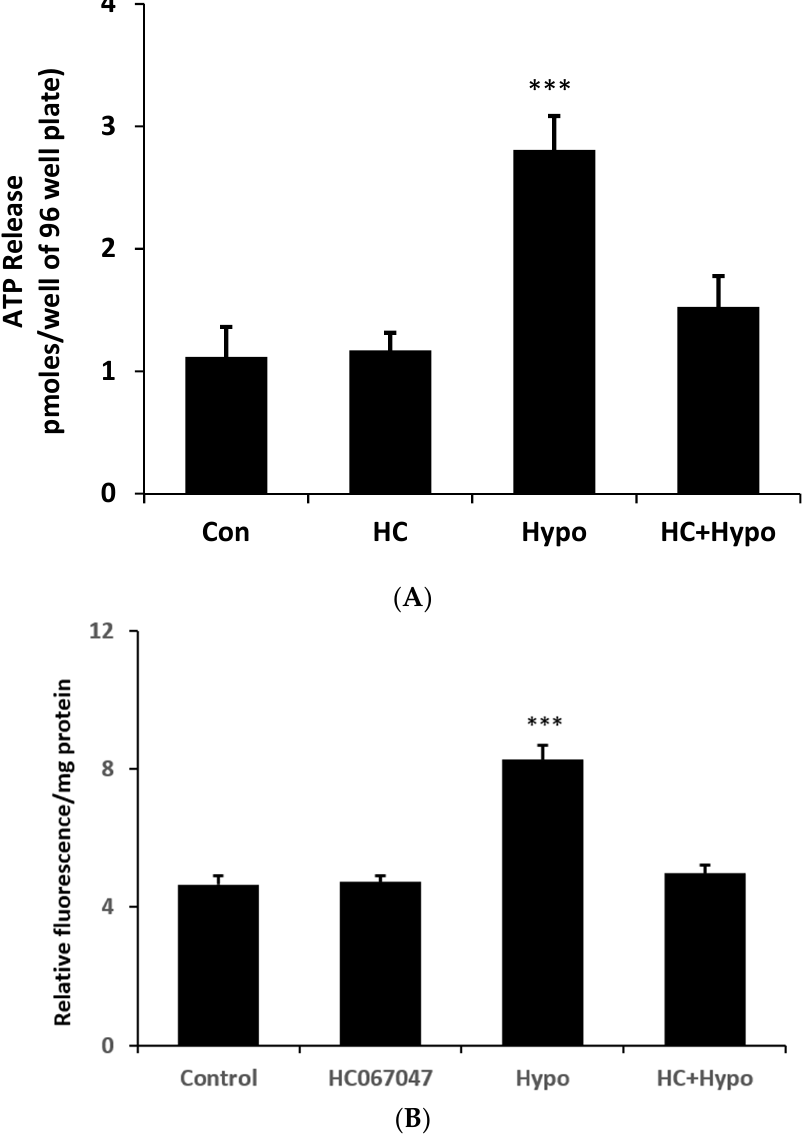
Figure 7. The TRPV4 antagonist HC067047 prevents ATP release and PI uptake responses to an osmotic swelling stimulus. The amount of ATP in the bathing medium ( A ) or cell PI fluorescence ( B ) was measured after exposing the monolayers of cultured NPE cells to hypoosmotic Kreb’s solution (200 mOsm) for 2 min in the presence or absence of HC067047 (10 µM) added 20 min beforehand. The data are the mean ± SE of results from twelve ( A ) or six ( B ) independent experiments. *** ( p < 0.001) indicates significant differences from control.